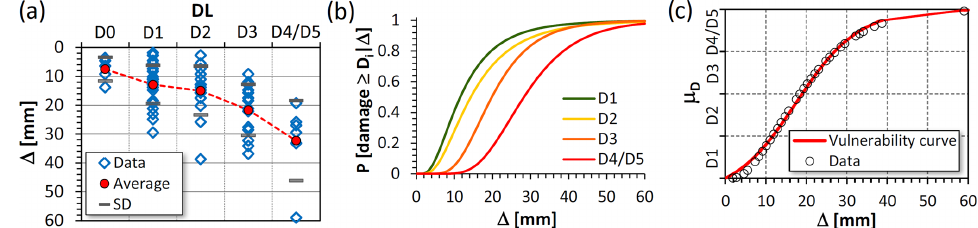
Figure 4. Empirical cause–effect relationships for masonry buildings in subsidence-affected urban area in terms of (a) damage severity level vs. differential settlements; (b) fragility curves and (c) vulnerability curve.